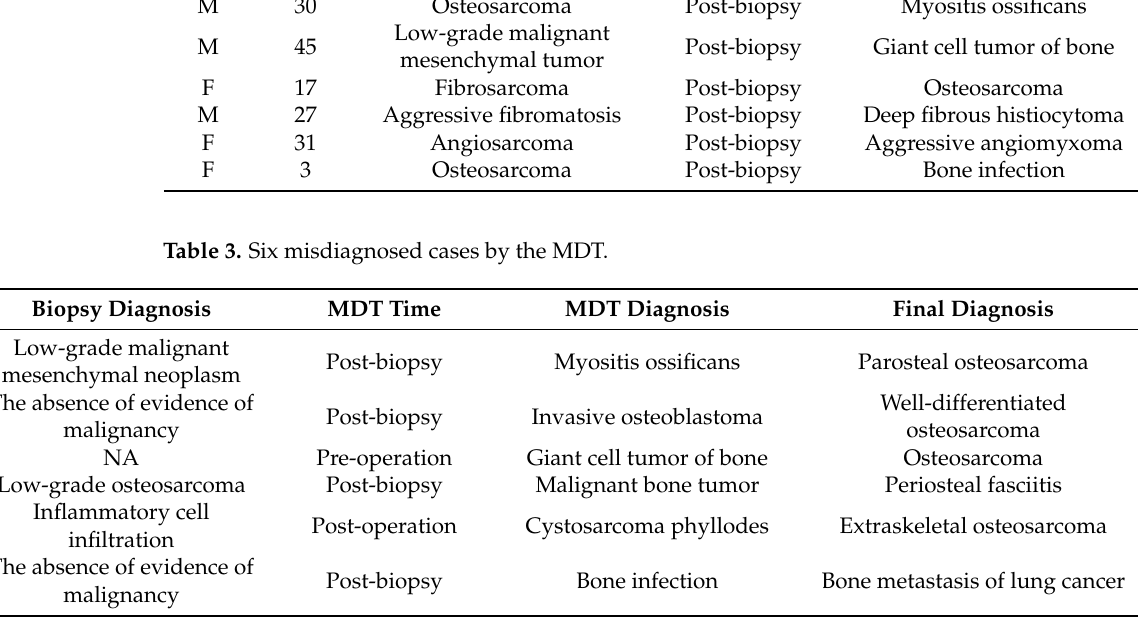
Table 3. Six misdiagnosed cases by the MDT.